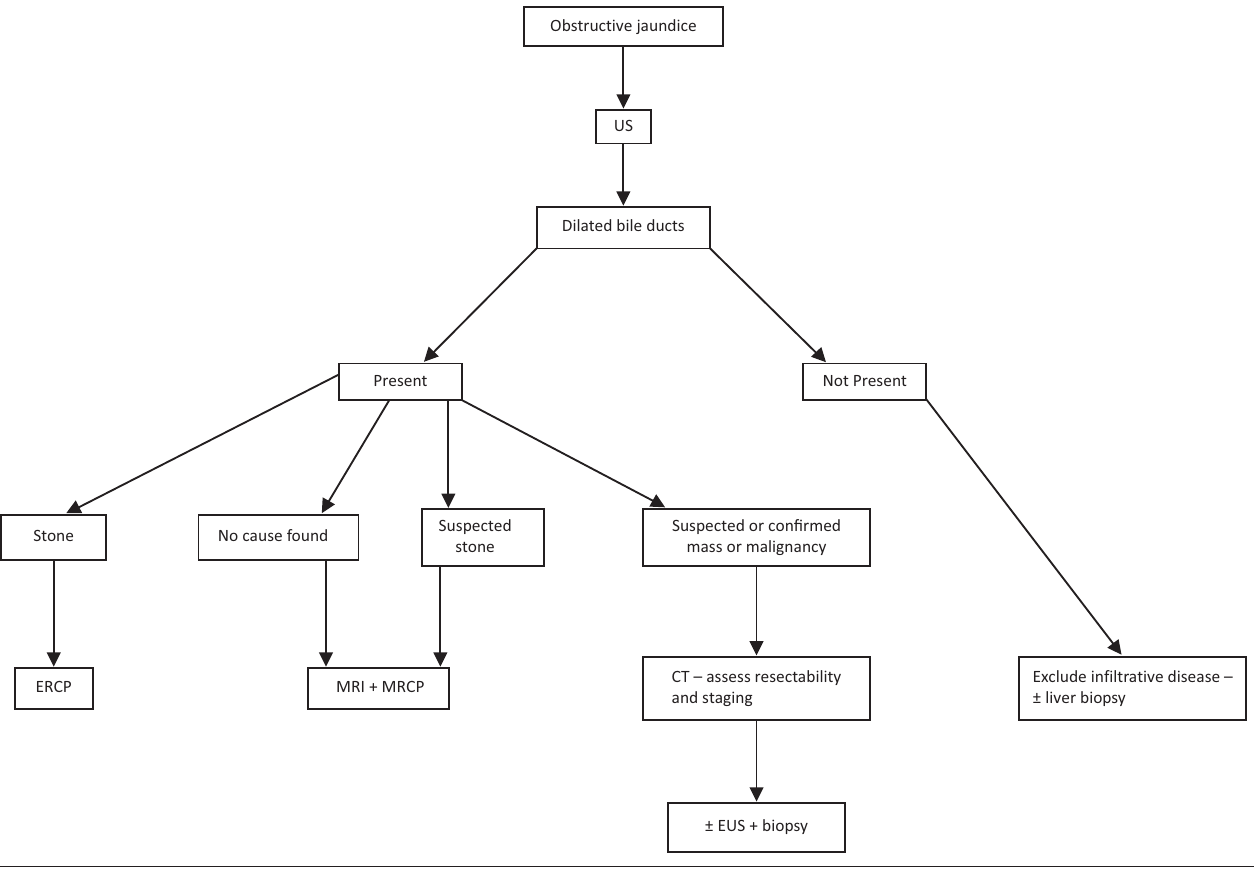
FIGURE 5: Referral approach for patients with obstructive jaundice.